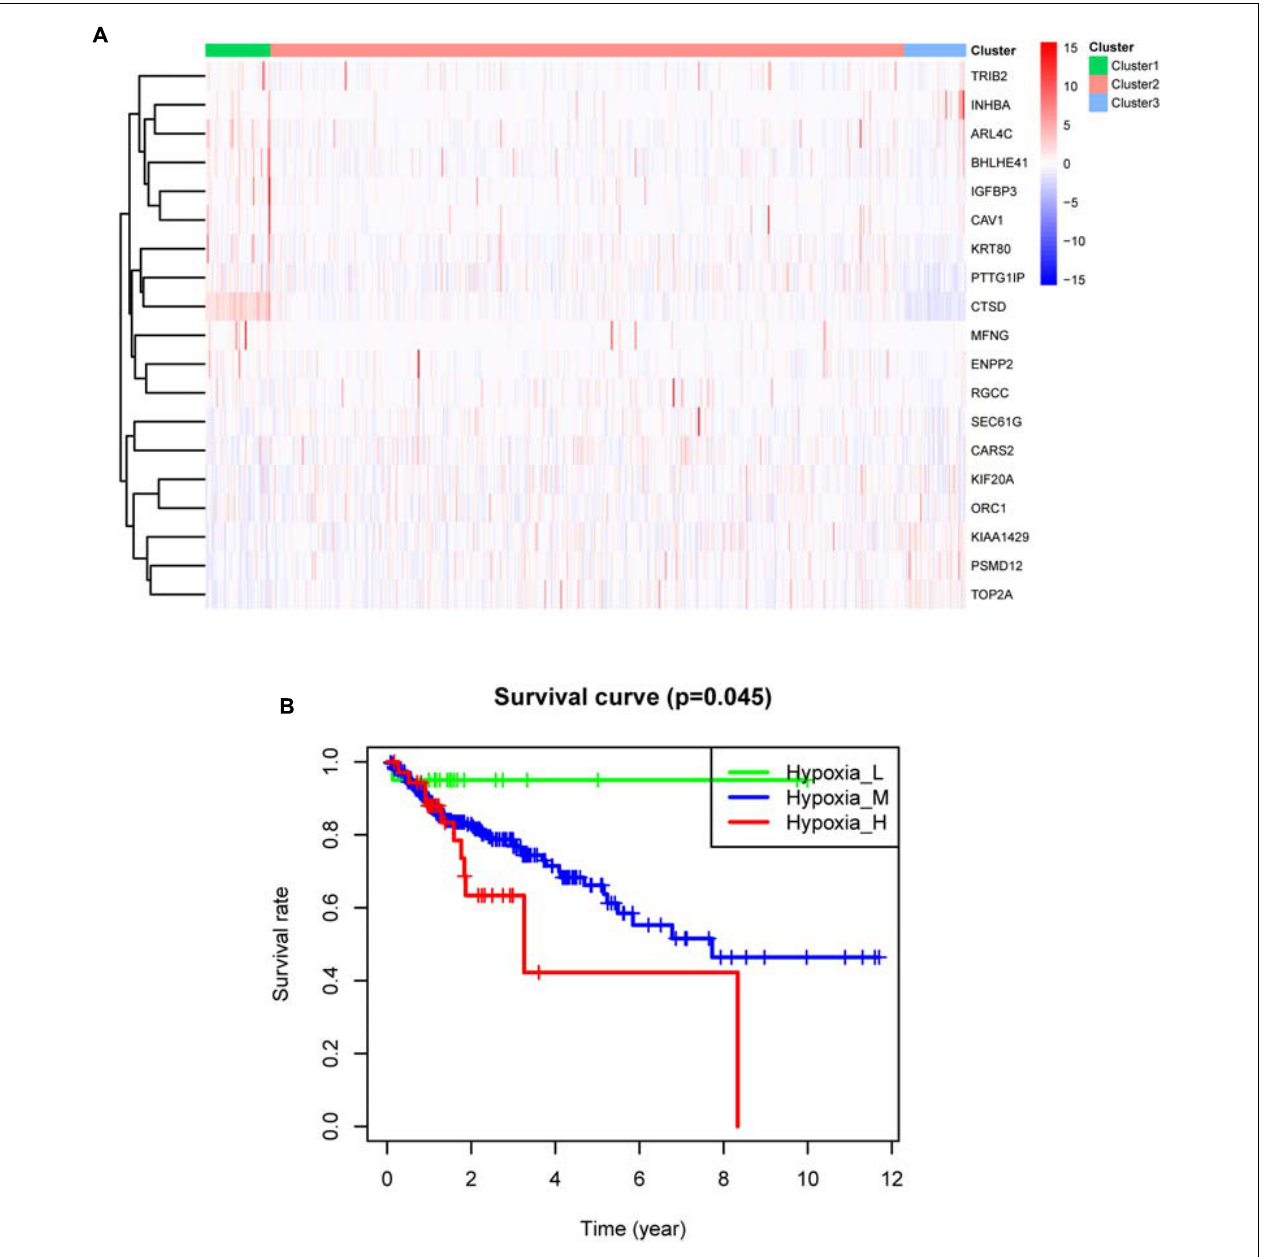
FIGURE 7 | TCGA-COAD sample clustering results. (A) Clustering heat map. In the center of the subfigure, high expression of the hypoxia gene is shown in red and low expression of the hypoxia gene is shown in blue. Cluster 1 is mainly red, representing high hypoxia group. Cluster 2 has red and blue, representing medium hypoxia group. Cluster 3 is mainly blue, representing low hypoxia group. (B) Kaplan–Meier survival curve. P < 0.05 indicates that there is a difference in survival among the three